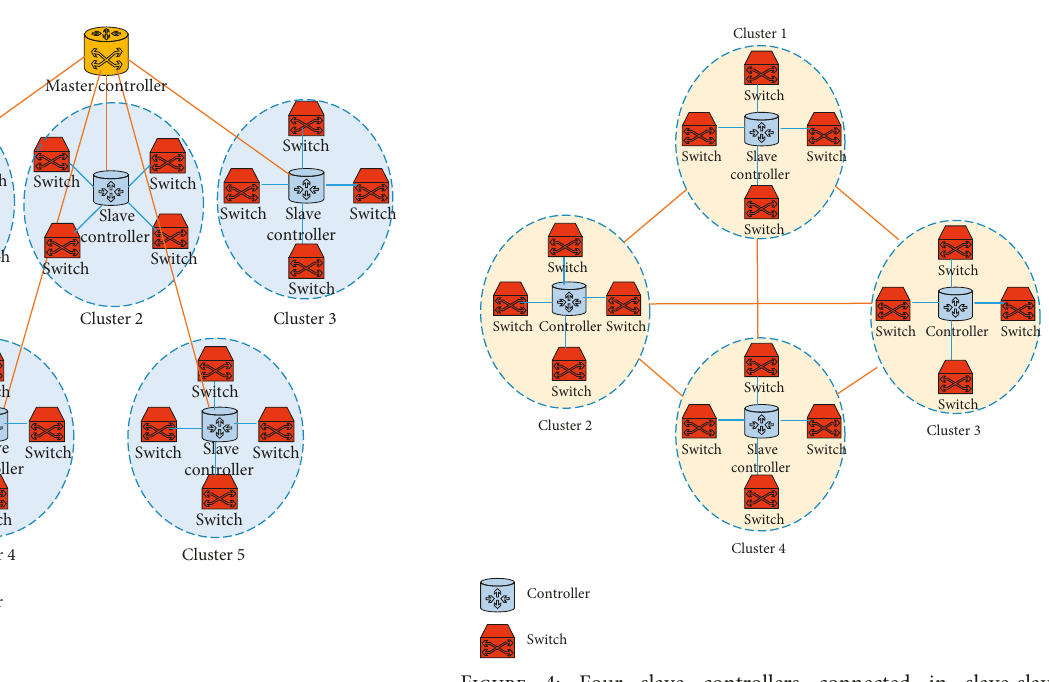
Figure 4: Four slave controllers connected in slave-slave